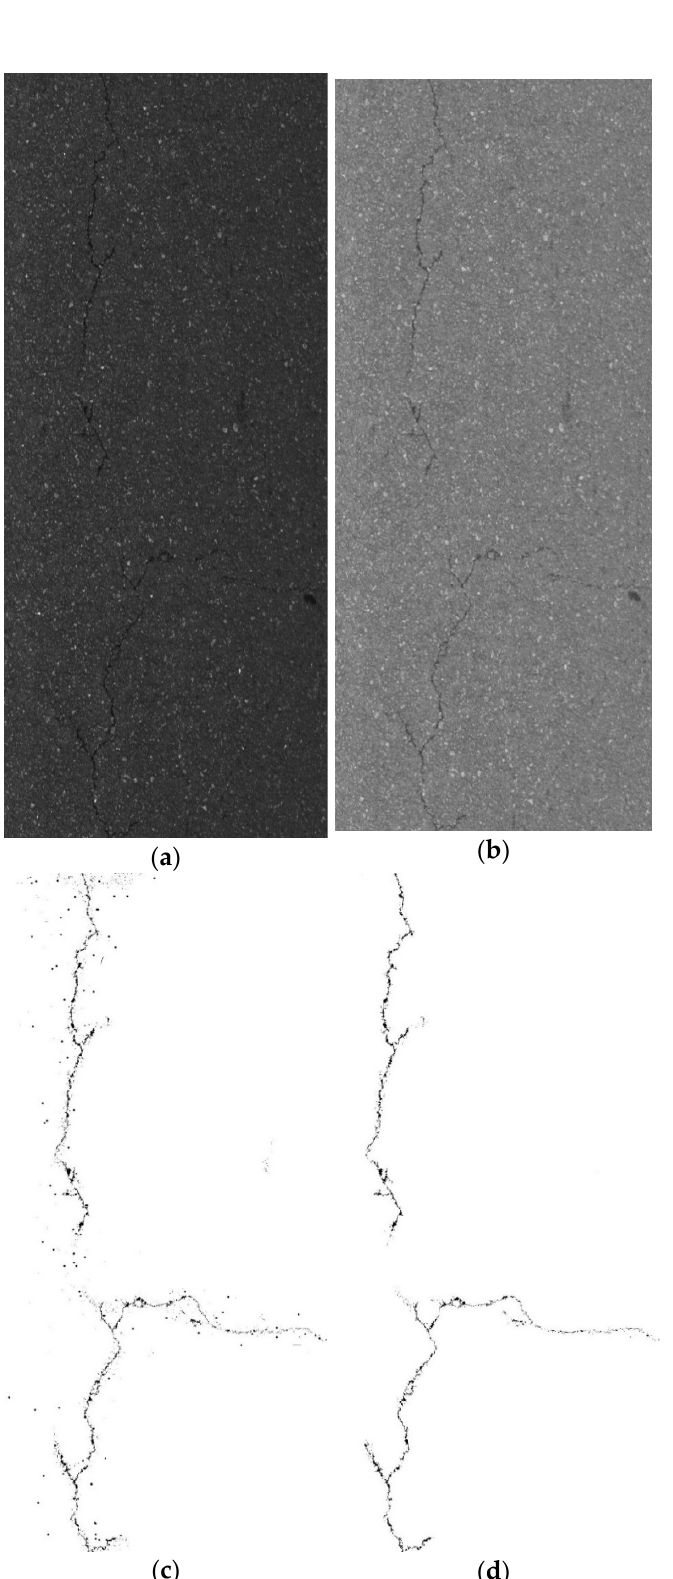
Figure 23. Longitudinal crack segmentation contrast experiment. ( a ) original images, ( b ) image enhanced by guided filtering and Retinex method, ( c ) images generated by traditional k-means clustering algorithm, ( d ) ours.